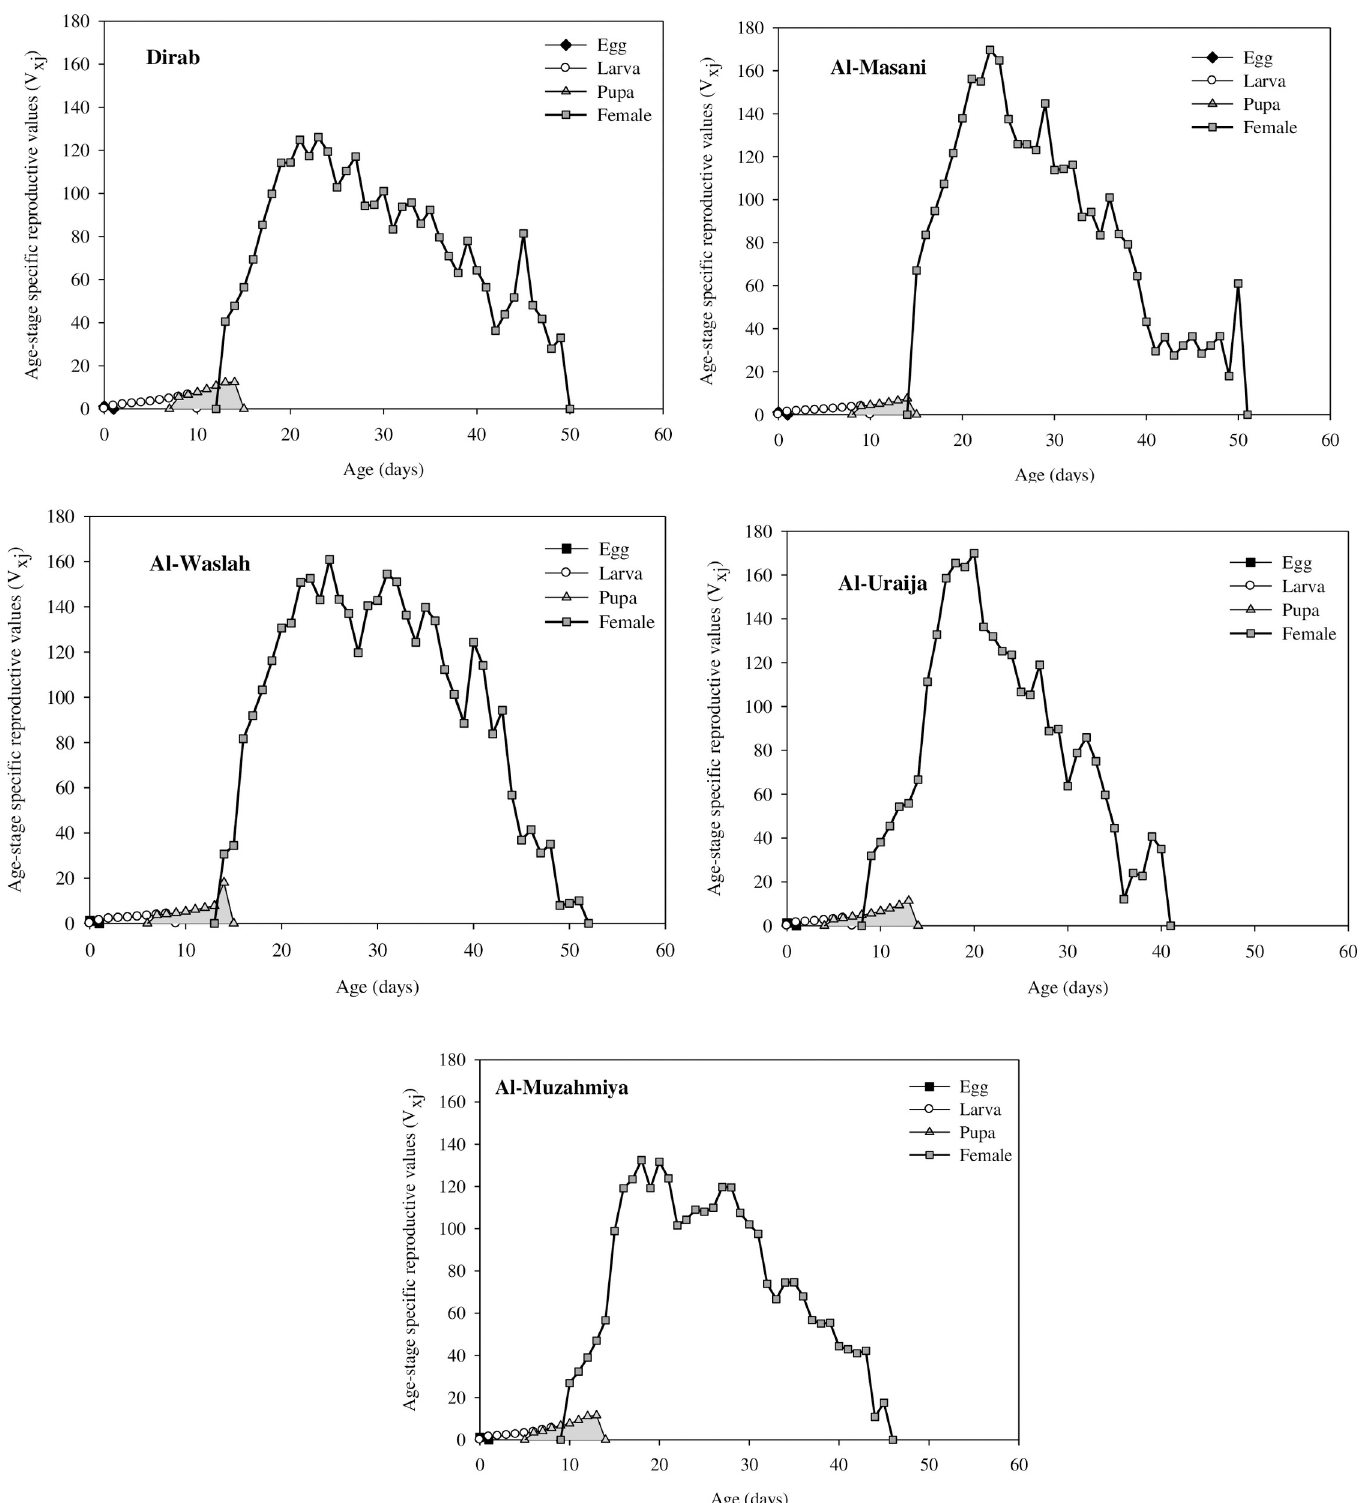
Fig 3. Age-stage-specific reproductive values (v xj ) for the Dirab, Al-Masanie, Al-Washlah, Al-Uraija, and Al-Muzahmiya populations of house fly.